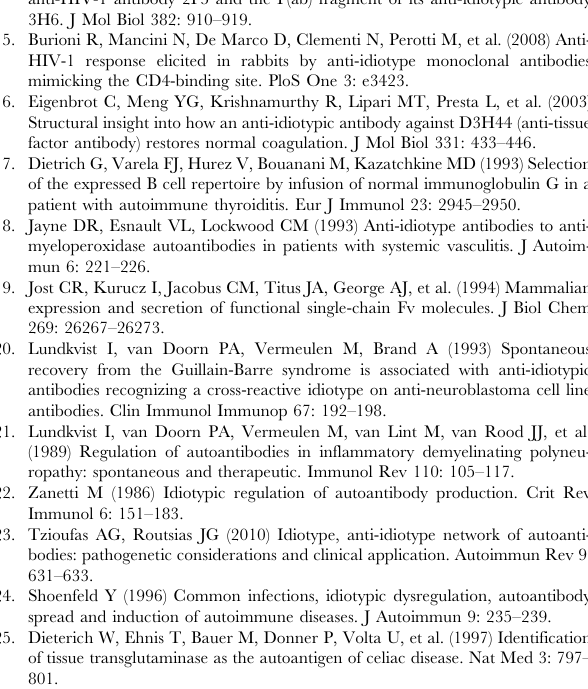
interface features of the six structure-known Ab1-Ab2 complexes. Table S3, list of 1DVF residues more than 50% buried upon complex formation. Table S4, cosine content of the first ten MD eigenvectors calculated for 1DVF and M1_CDR. Figure S1, intermolecular contact maps generated by COCOMAPS for the M1-CDR model and the six experimental structures available for Ab1-Ab2 complexes. Figure S2, RMSD fluctuation and Gyration radius, R c , for M1-CDR, M2-CDR, M1-blind and 1DVF along the MD simulations. Figure S3, LGA superimposition between the N-terminal domain of TG2 in its open form and the heavy chain of